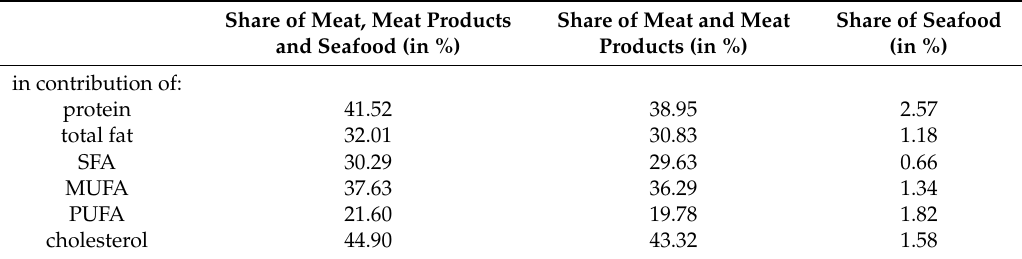
Table 3. The share of meat, meat products and seafood in contribution of protein, total fat, SFA, MUFA, PUFA and cholesterol in the average Polish diet. Share of Meat, Meat Products Share of Meat and Meat Share of Seafood and Seafood (in %) Products (in %) (in %) in contribution of: